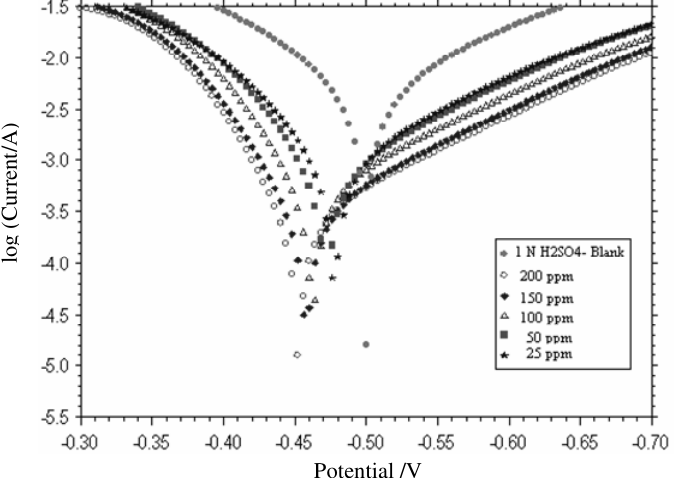
Figure 1. Tafel plots showing effect of F. exasperata extracts on corrosion of MS in H